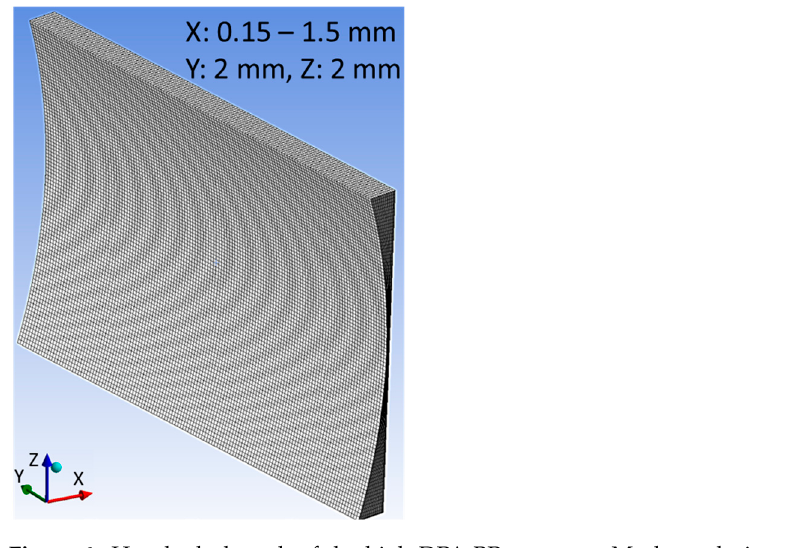
Figure 6. Hexahedral mesh of the high-DPA BP segment. Mesh resolutions are X: 0.15–1.5 mm, Y: 2 mm, and Z: 2 mm, which provide similar resolutions as the mesh tallies to maintain the data’s fidelity.